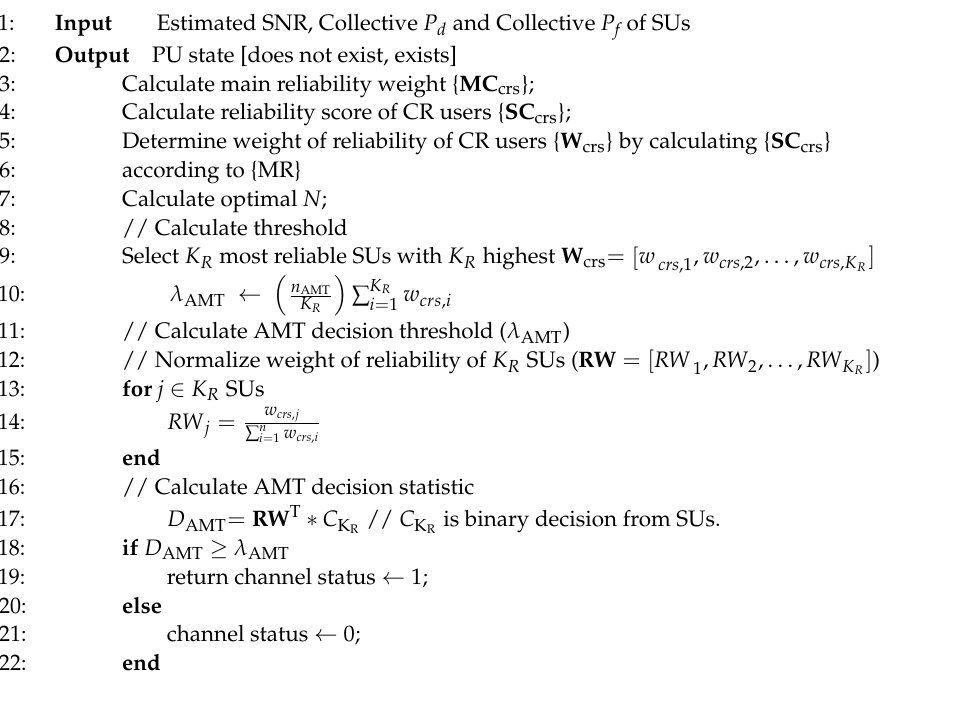
Algorithm 1. PU state